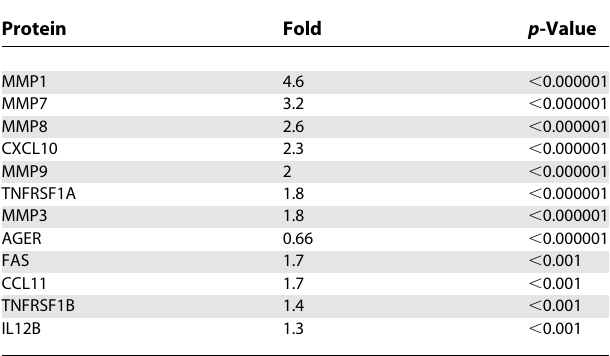
Table 3. Plasma Proteins That Distinguish IPF from Controls Protein Fold